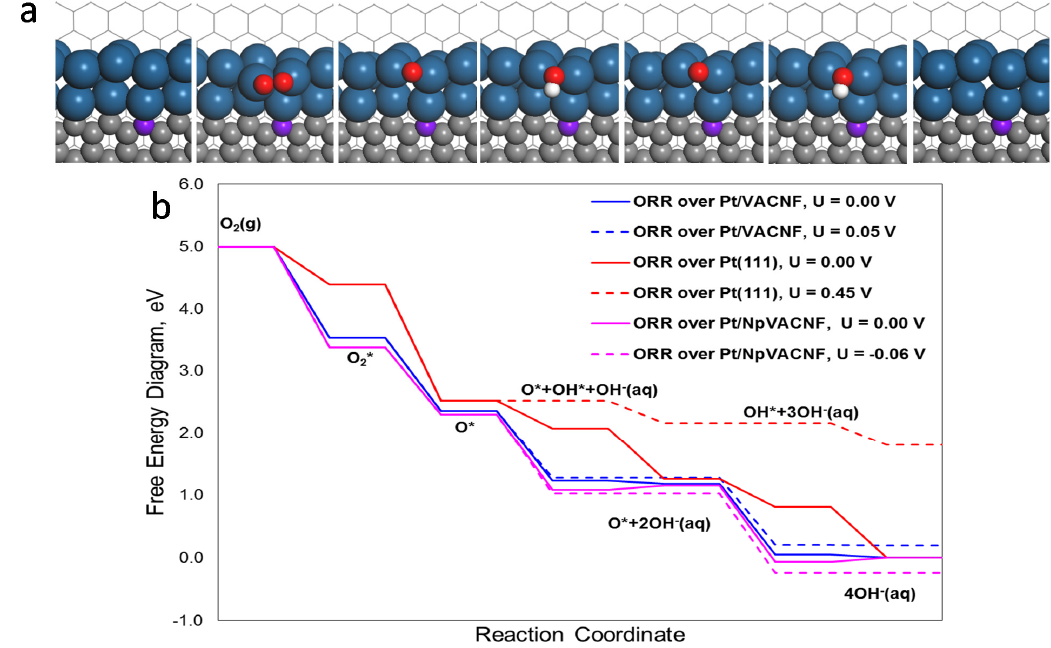
Figure 5. ( a ) Molecular structures of the most stable ORR intermediates over Pt/N p VACNF; ( b ) Free energy diagram of the 4-e − pathway for ORR on Pt/N p VACNF (pink) compared with Pt (111) (red) and Pt/VACNF (blue) by both associative (dotted) and dissociative (solid) mechanisms. Color code: blue-Pt, gray-C, purple-N, red-O, white-H.